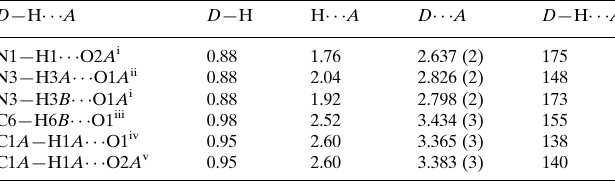
Hydrogen-bond geometry (A ˚ , (cid:4)